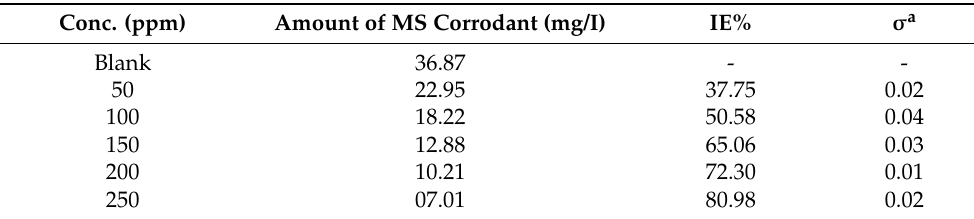
AAS study of T. aralioides in 1M HCl with and without inhibitor at different concentrations (303 ± 1 K).